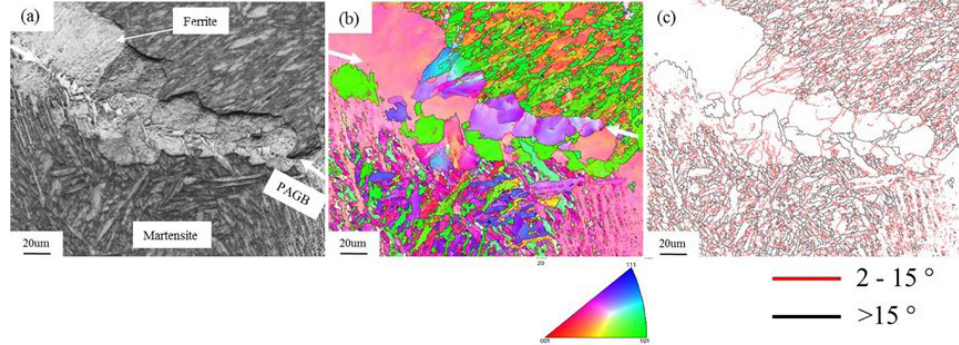
Figure 5. Grain boundary ferrite morphology at 3mm/120s, (a) SEM image, (b) inverse pole figure (IPF), (c) angle distribution.